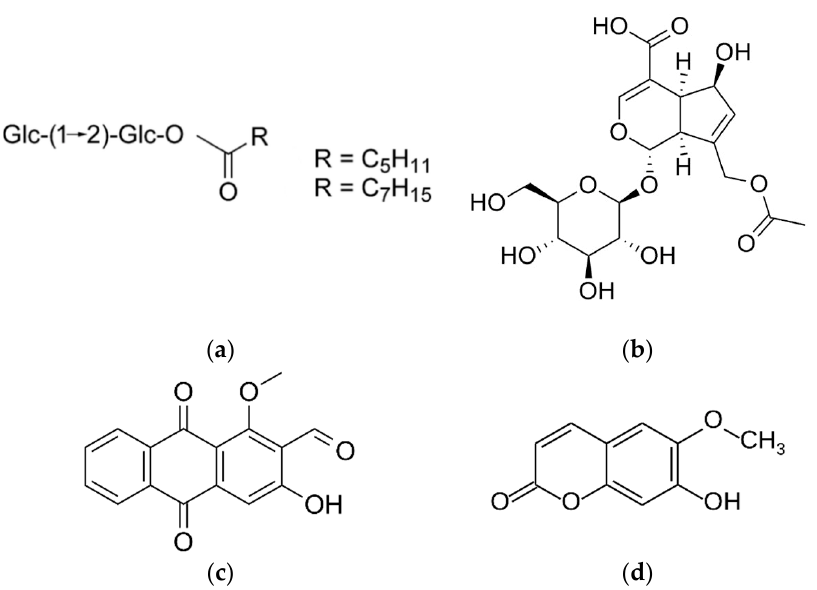
Figure 6. Chemical structure of cytotoxic saccharide fatty acid esters ( a ), asperulosidic acid ( b ), adamnacanthal ( c ), and escopoletin ( d ) present in M. citrifolia L. adamnacanthal ( c ), and escopoletin ( d ) present in M. citrifolia L. 8.9. Orthosiphon aristatus (Blume) Miq. 8.9. Orthosiphon aristatus (Blume) Miq.